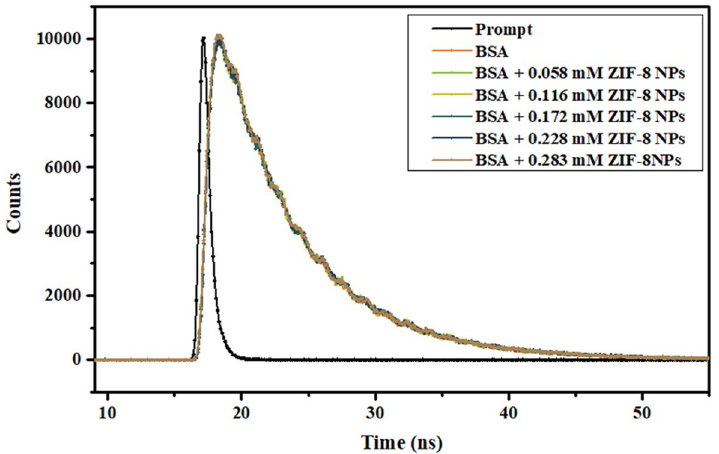
Figure 5. Time-resolved fluorescence study of BSA in presence of different concentration of ZIF-8 NPs.